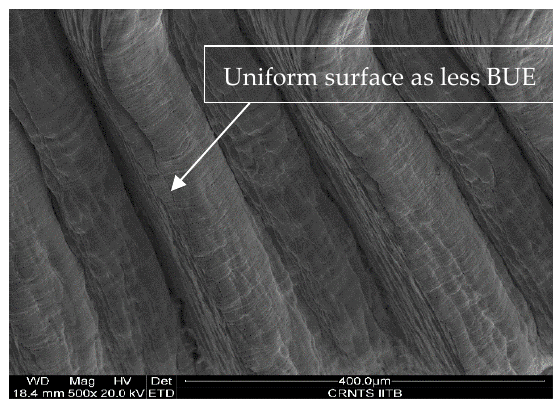
Figure 6. Chips cross-section with initial parameters.